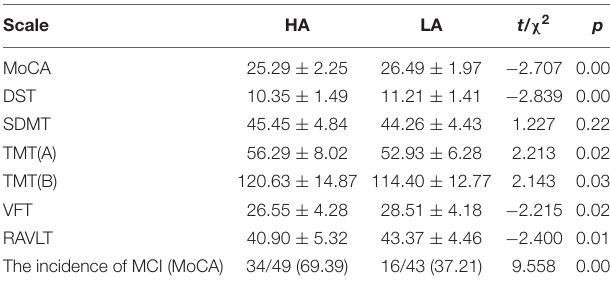
TABLE 2 | Neuropsychological scale scores for subjects in the two